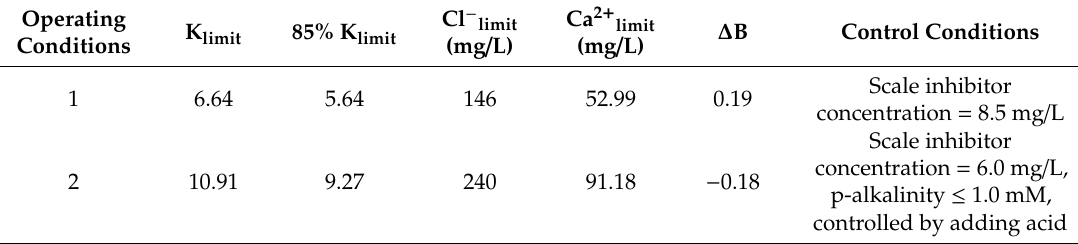
Table 5. The results of scale-inhibition reduction test.